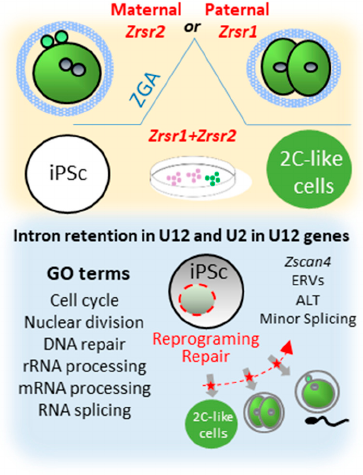
Figure 4. Synopsis of phenotypes produced by Zrsr1 and Zrsr2 mutations . Upper panel shows that mutation of maternal Zrsr2 and paternal Zrsr1 blocked early embryo development during zygotic gene activation (ZGA) and increased intron retention in U2- and U12-containing genes; and that mutation of either Zrsr1 or Zrsr2 led to a blockade of induced pluripotent stem cell (iPSC) conversion to 2C-like cells. The bottom panel shows gene ontology (GO) enrichment terms related to these phenotypes, indicating that disturbed U12-containing genes are critical for cell division, di ff erentiation, and DNA damage